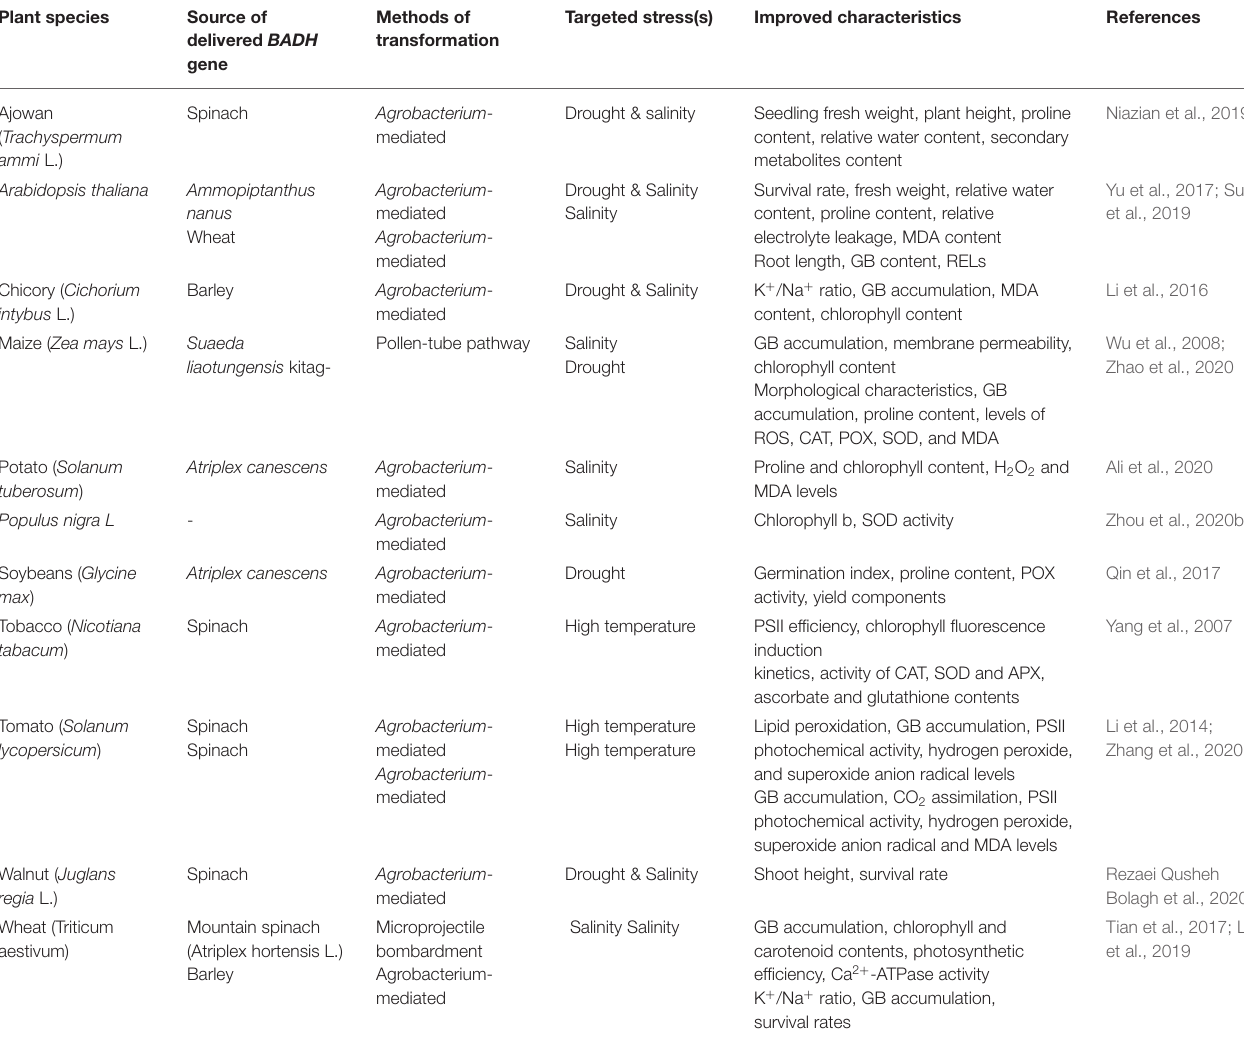
TABLE 1 | Examples of transferred BADH genes to enhance abiotic stresses in different plants species. Plant